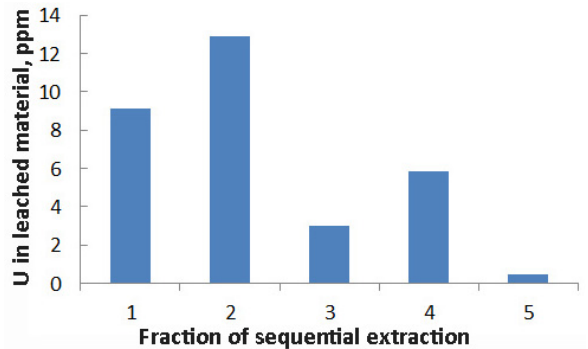
Figure 4. Average distribution of uranium in leached material of fractions 1–5 (ppm of leached material). Legend is in Figure 3.